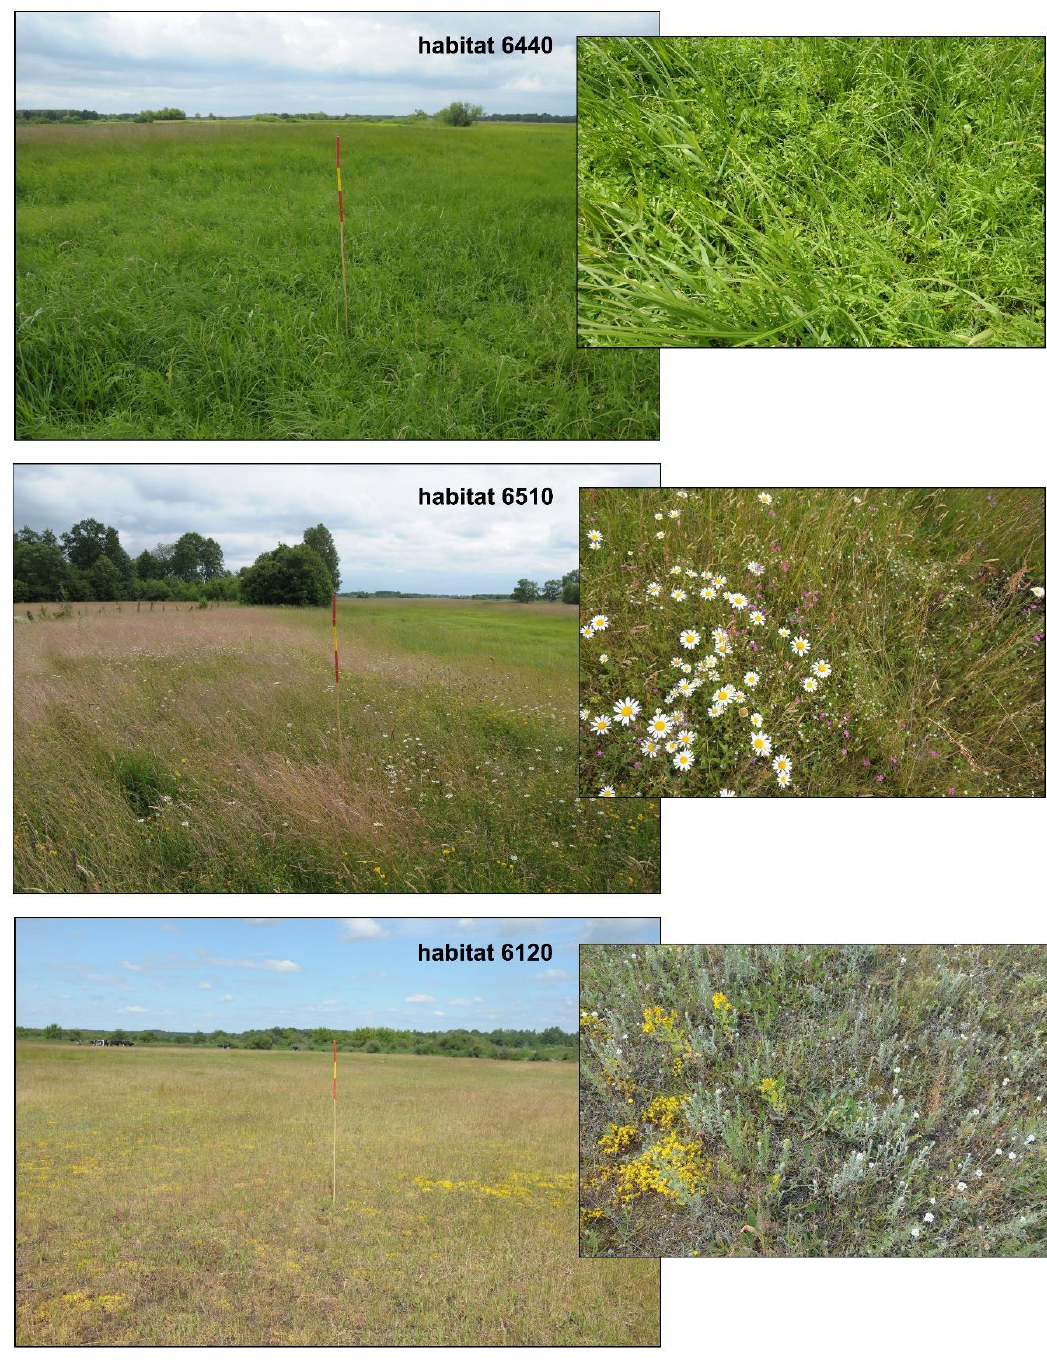
Figure 3. Field pictures of the analyzed Natura 2000 habitats.